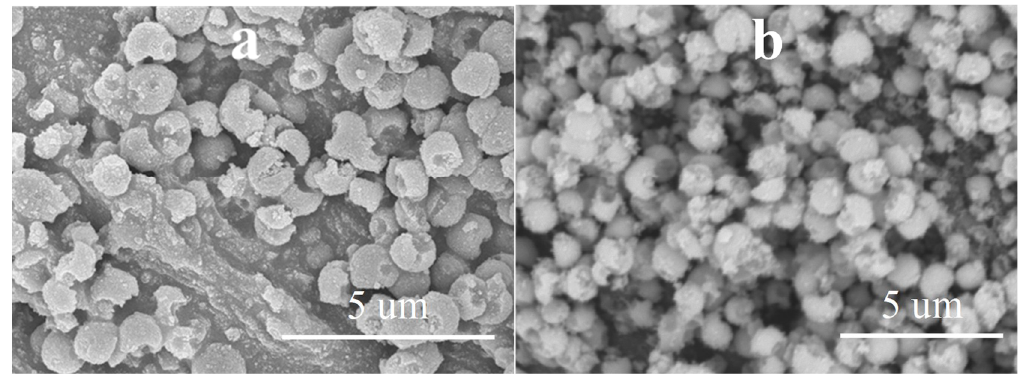
Figure 13. SEM micrographs of H2_HS_5 before ( a ) and after ( b ) the 3 consecutive phenol degradation tests (H2_HS_5_rep).